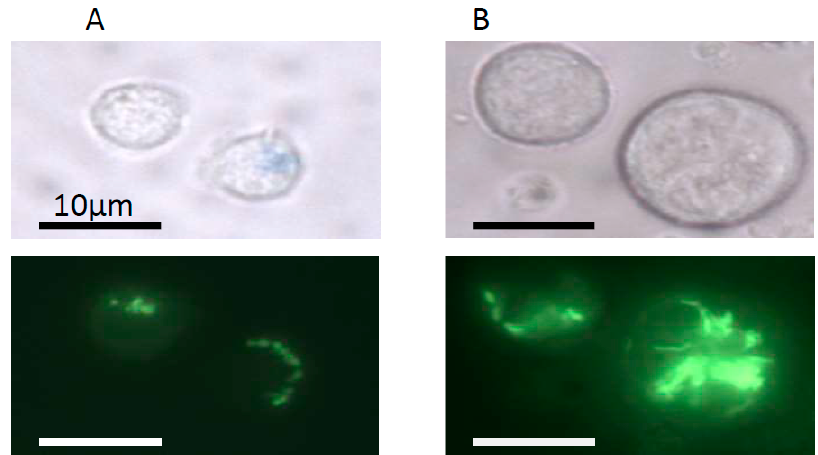
point 4.8 in materials and methods section.